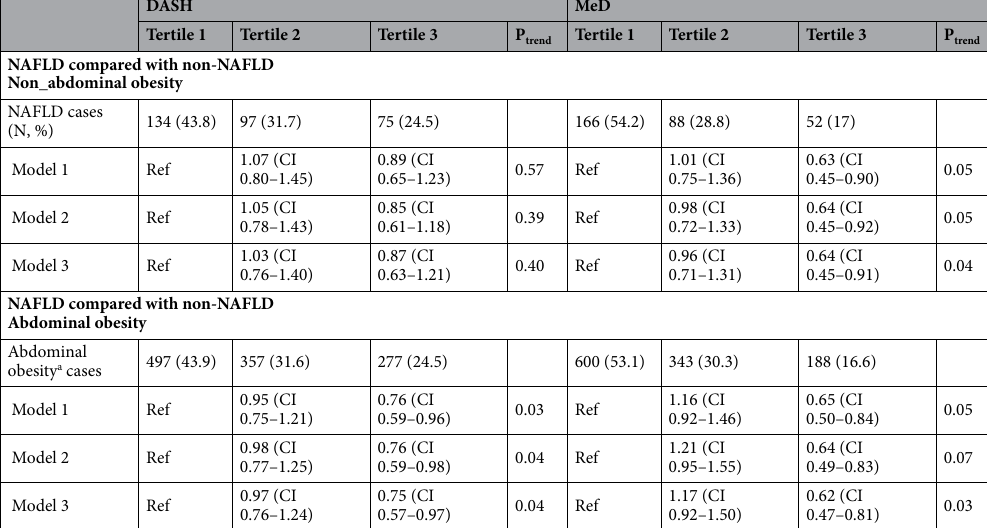
Table 4. Multivariable-adjusted odds ratio and 95% confidence intervals for nonalcoholic fatty liver disease (NAFLD) according to tertiles (T) of dietary patterns in all adult participants stratified by waist circumference, Amol Cohort Study, Iran, 2016–2017 (n = 3220). DASH: dietary approaches to stop hypertension, MeD: Mediterranean diet, Ref: reference category. Model 1: adjusted for age and sex. Model 2: additional adjustment for BMI, energy intake, physical activity, and smoking. Model 3: additional adjustment for Lowering serum lipid drugs, Lowering HPTN drugs, Lowering serum glucose drugs, residual areas, heart disease, diabetes. a Abdominal obesity: waist circumference > 102 cm for men and > 88 cm for